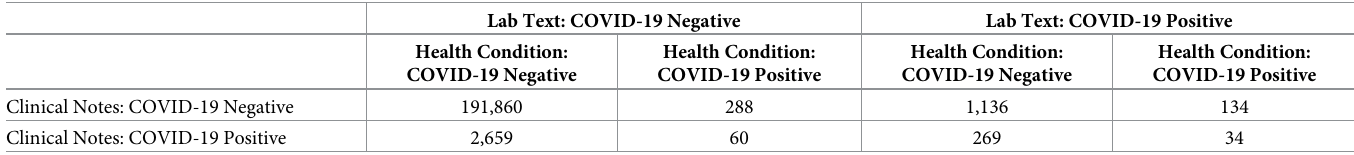
Table 3. A three-way cross-tabulation comparing the number of COVID-19 positive indications (at a patient-level) from the lab text, health condition diagnosis text and clinical note data streams.